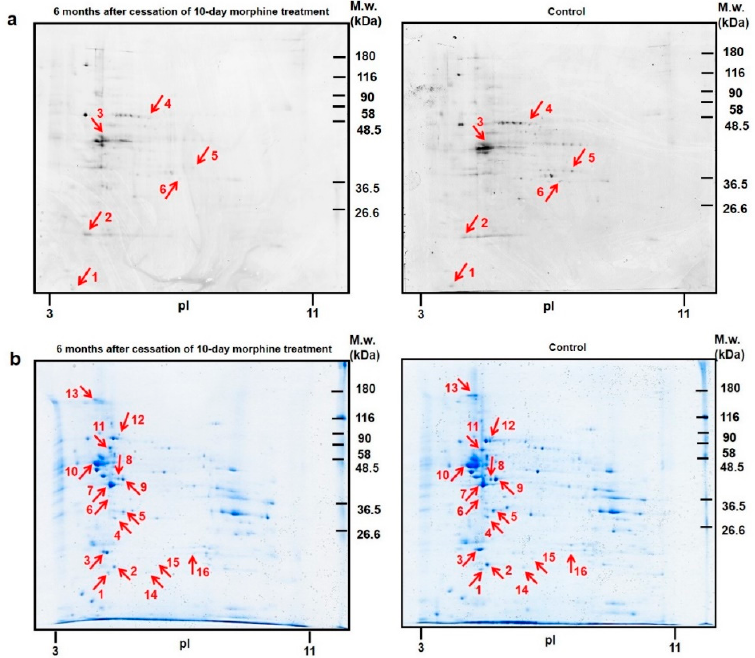
Figure 1. Representative 2D gel maps of phosphorylated proteins ( a ) and total protein profiles ( b ) in the rat hippocampus isolated from animals after 6 months of morphine withdrawal. Red arrows and numbers show the significantly altered protein